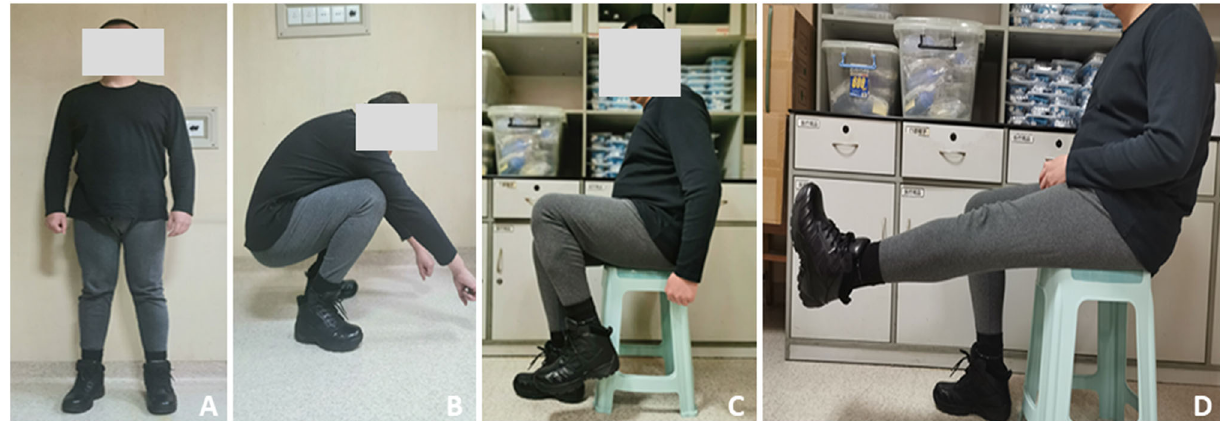
Fig. 4 The lower limb function of the second typical case at the last follow-up. As displayed, his loading and motion function of both legs were satisfactory. A Stand, B Crouch, C Bend leg, and D Straight